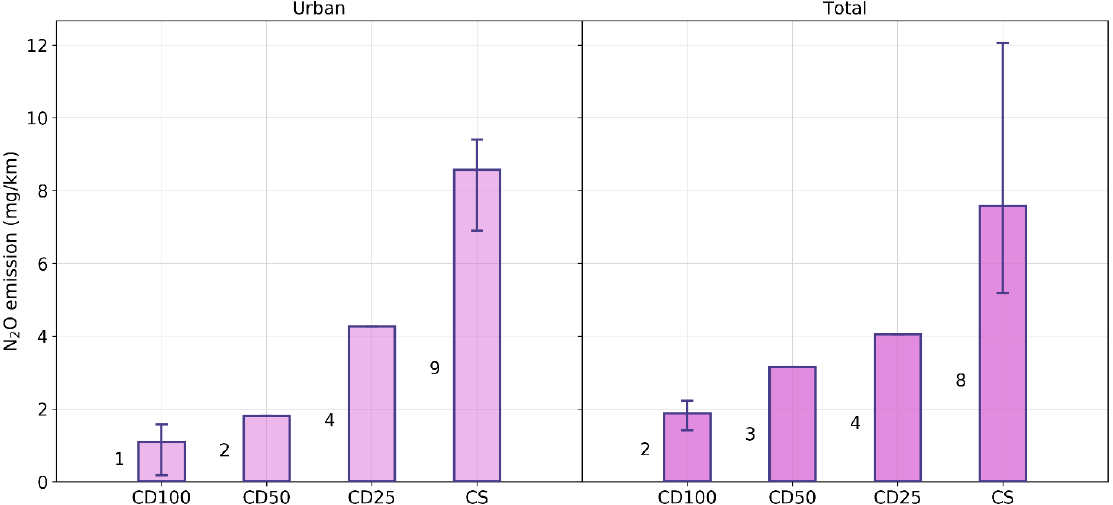
Figure 4. Emissions of N 2 O in RDE tests. CD100/50/25 indicate charge depleting operation with battery initial State of Charge (SOC) equal to 100/50/25%; CS indicated charge sustaining operation, i.e., starting with the minimum SOC. Left panels report emissions for the urban phase, right panels for the complete test. All tests were performed in the default user selectable mode of operation. Error bars on the graph represent maximum and minimum values for conditions having more than one test. See Methods section for additional details.